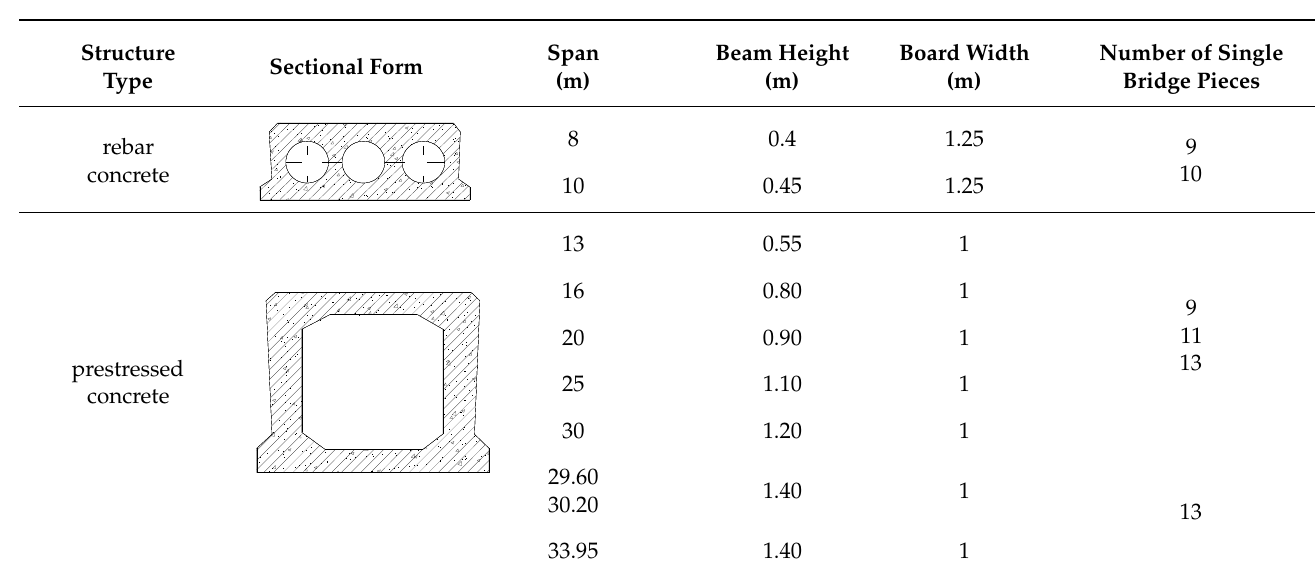
Table 2. Key parameters of the simply supported hollow slab bridge on the Pingli Highway.